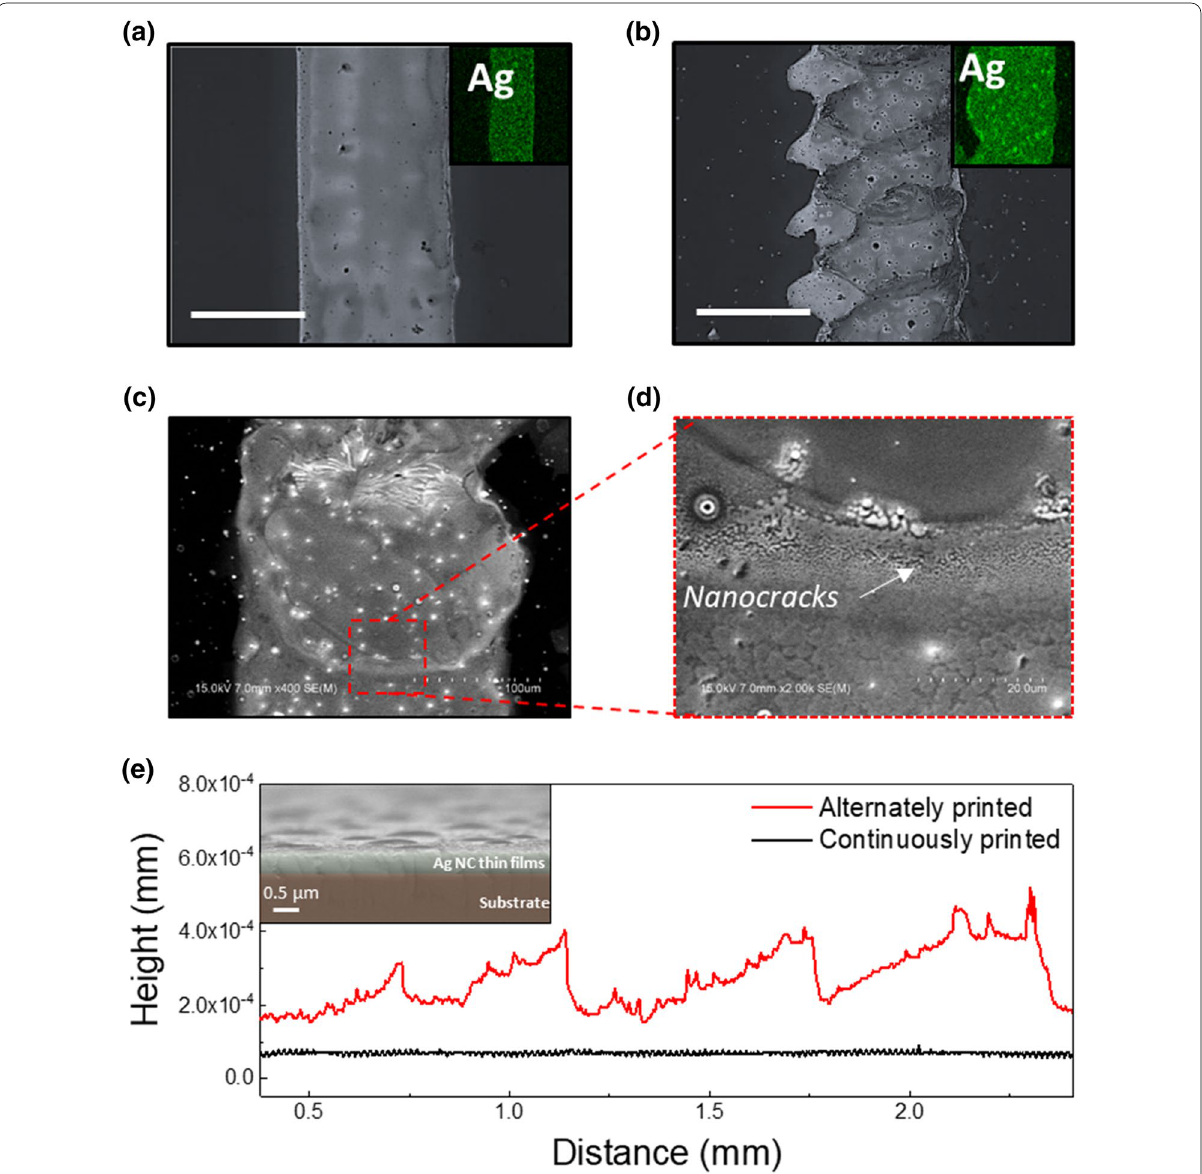
Fig. 2 Optical microscopic images of NH 4 Br-treated Ag NC thin films with a continuously and b alternately printed line patterns (scale bar 250 μm); insets show energy-dispersive X-ray spectroscopic mapping images for Ag Lα 1. c Scanning electron microscopy (SEM) image of = an alternately printed line pattern whose magnified version is shown in d . e Heights of the developed patterns determined using an Alpha-Step profilometer (inset cross-sectional SEM image of as-deposited Ag NC thin =